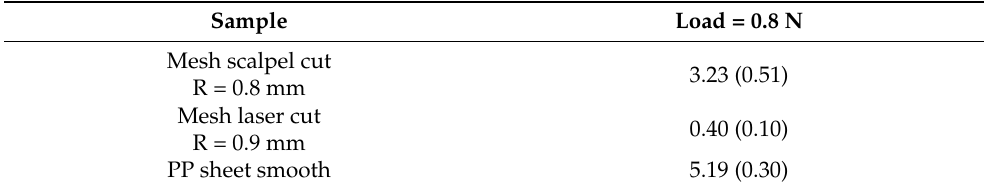
Table 3. Erosion rate (in mm/m) for tests conducted with a stroke length of 2 mm. Averages from at least 5 results per group: standard deviation in brackets. Table 4. Erosion rate (in mm/day) for tests conducted with static loading. Averages from at least 5 results per group: standard deviation in brackets.